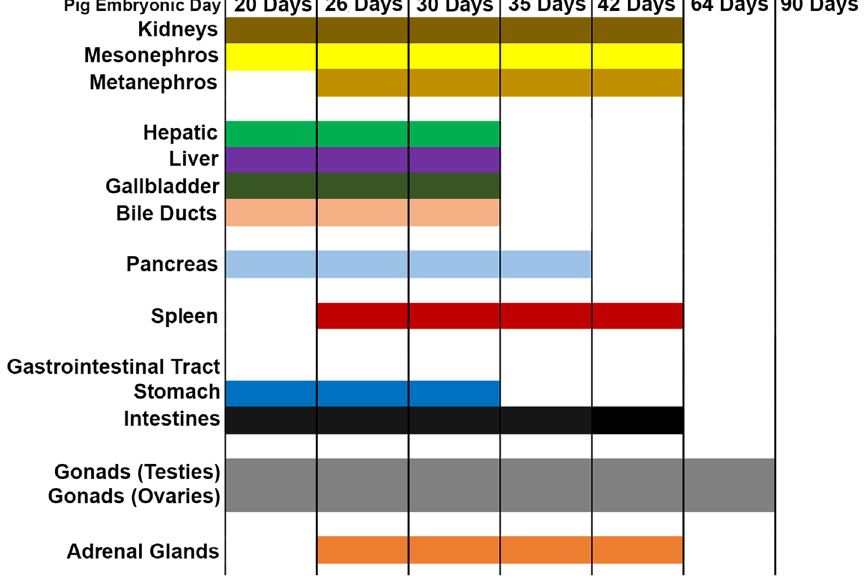
Figure 8. Timeline of the gross morphologic development of the abdominal organs in the pig ( Sus scrofa) . The cells at the top of each column of the graph indicate the gestational age that the studied organs appear to have obtained their distinct shape and expected gross appearance of their parenchyma but do not indicate the final stages of development which continue to develop in size as well as at the cellular and molecular levels